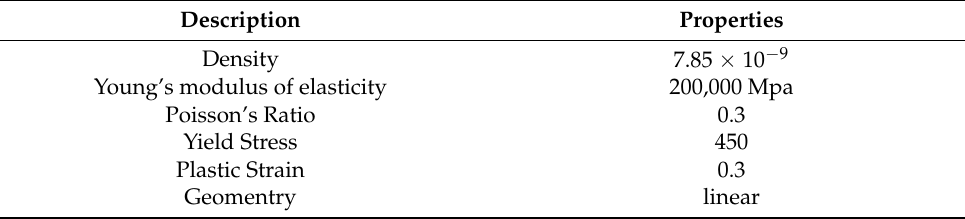
Table 4. Steel fibers properties.